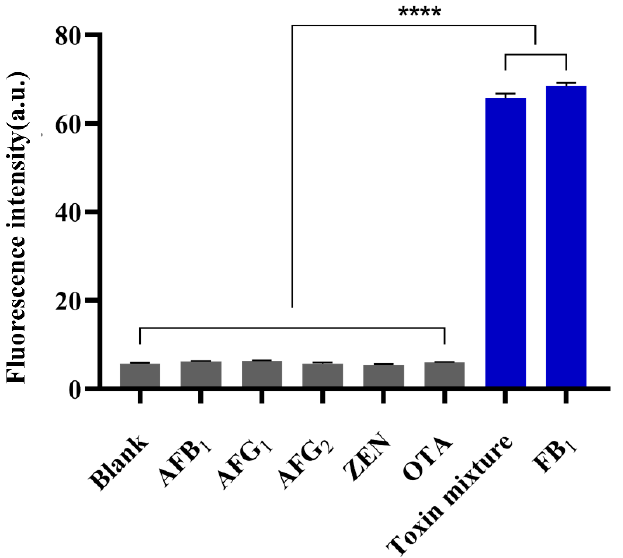
Figure 2. Specificity of the sensor for the detection of FB 1 . (Toxin mixture included AFB 1 , AFG 1 , ZEN, OTA and FB 1 , **** p < 0.001). ZEN, OTA and FB 1 , **** p <